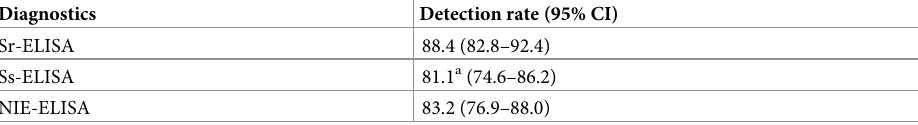
Table 1. Detection rates of urine ELISA protocols based on antigens prepared from S . ratti , S . stercoralis and recombinant protein (NIE) of S . stercoralis evaluated against the fecal examination (n = 966). Data shown are detection rate and 95% confidence